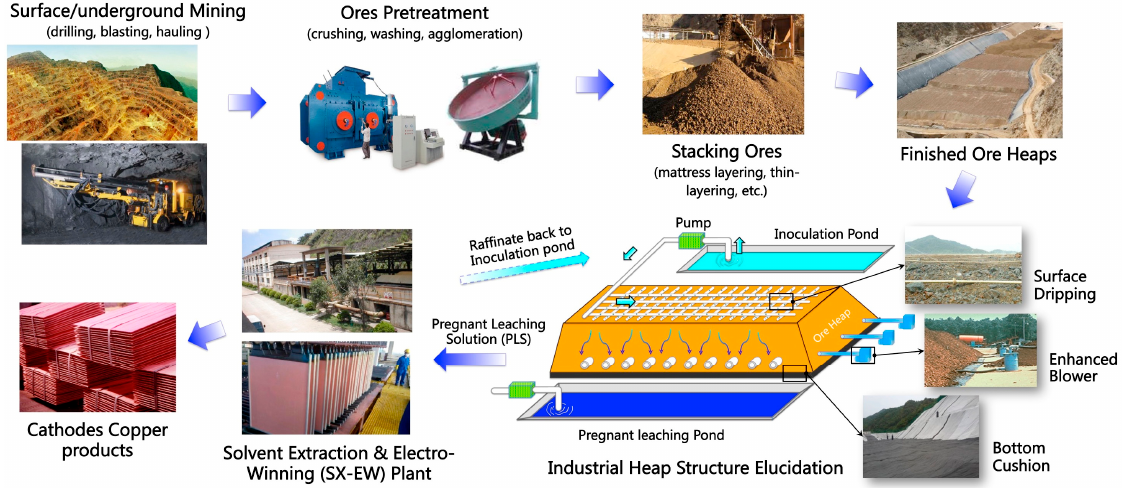
Figure 1. Typical industrial schematic of copper bioheap leaching.